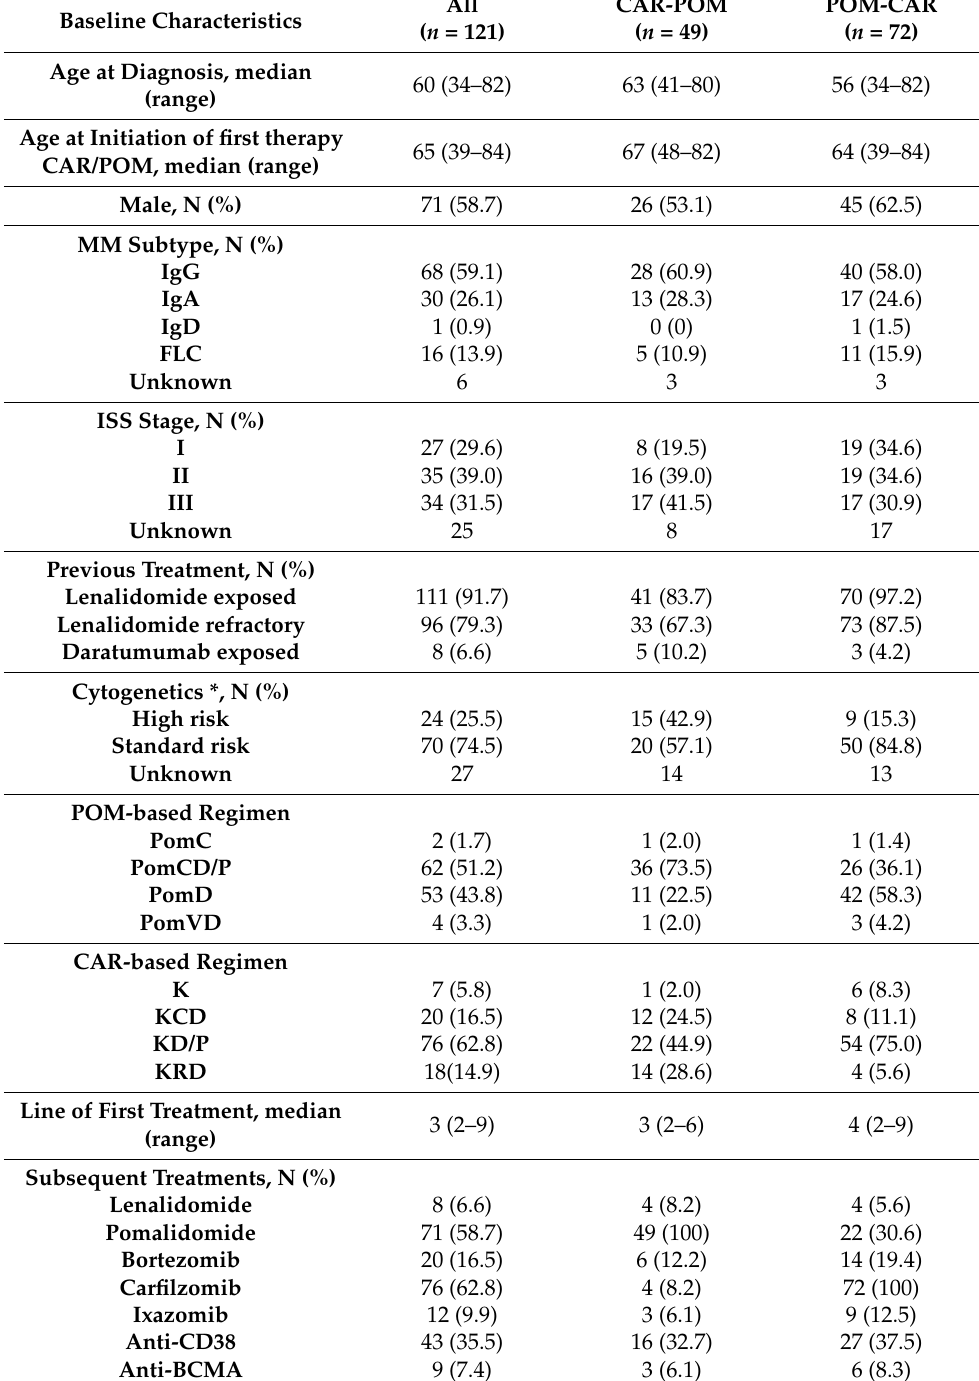
Table 1. Baseline characteristics and treatment details of all patients stratified by the sequential use of carfilzomib and pomalidomide based